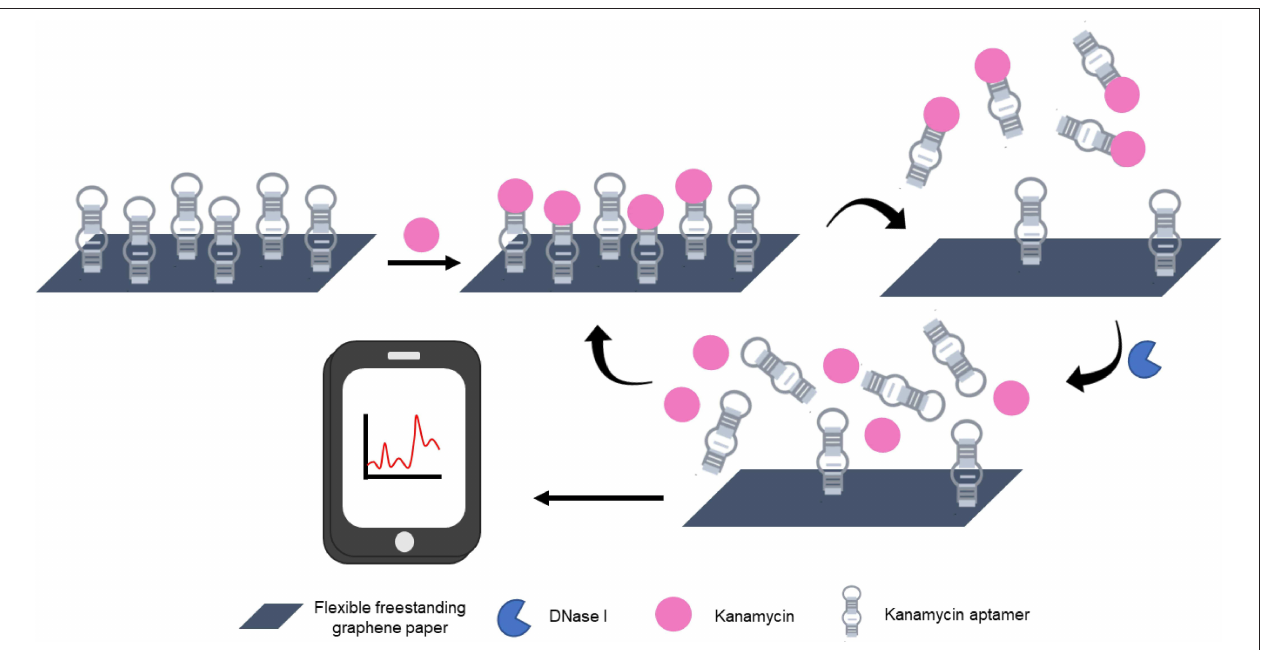
FIGURE 10 | Schematic diagram of the sensing principle behind aptamer-based kanamycin detection using freestanding graphene paper (GNP) and nuclease-assisted amplification strategy ( Yao et al.,